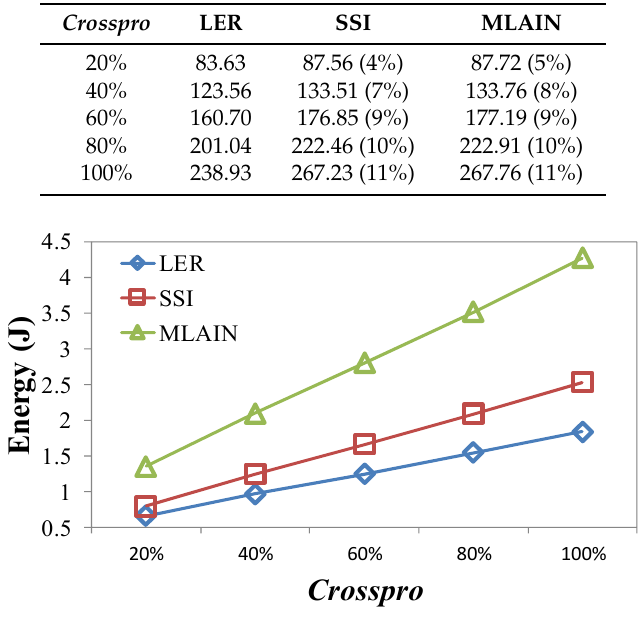
Figure 8. Average energy consumption for changing Crosspro values.